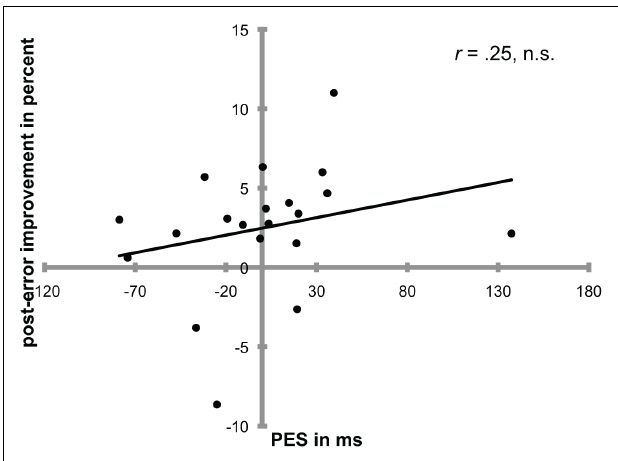
FIGURE 1 | Post-error slowing and post-error improvement in accuracy (PIA) did not correlate significantly in a colored-moving dot interference task (Danielmeier et al., 2011). Participants showed either both PES and PIA (upper right quadrant) or only PIA without PES (upper left quadrant). One participant showed only PES without improvement and two subjects showed neither PES nor PIA following